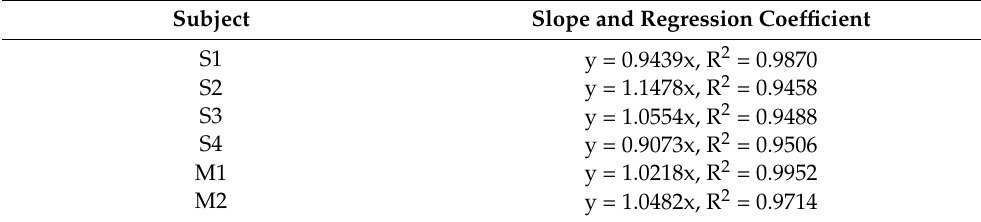
Figure 5. Facial illuminance calculated after the methodology proposed with the Samsung S6 Edge Plus smartphone camera when using the phone a regular way, as in Figure 2-right ( Y -axis) is plotted against illuminance measurements made with the phone’s on the face with the light meter facing the position where the phone is regularly used, as in Figure 2-left ( X -axis). Table 2. Slope values and regression coefficients corresponding to the regression fit lines of Figure 5.